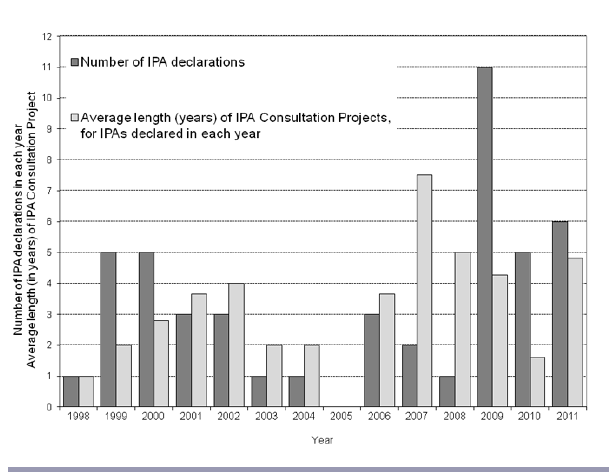
Fig. 2 . Indigenous protected area (IPA) Declarations by year and mean length (years) of IPA Consultation Projects